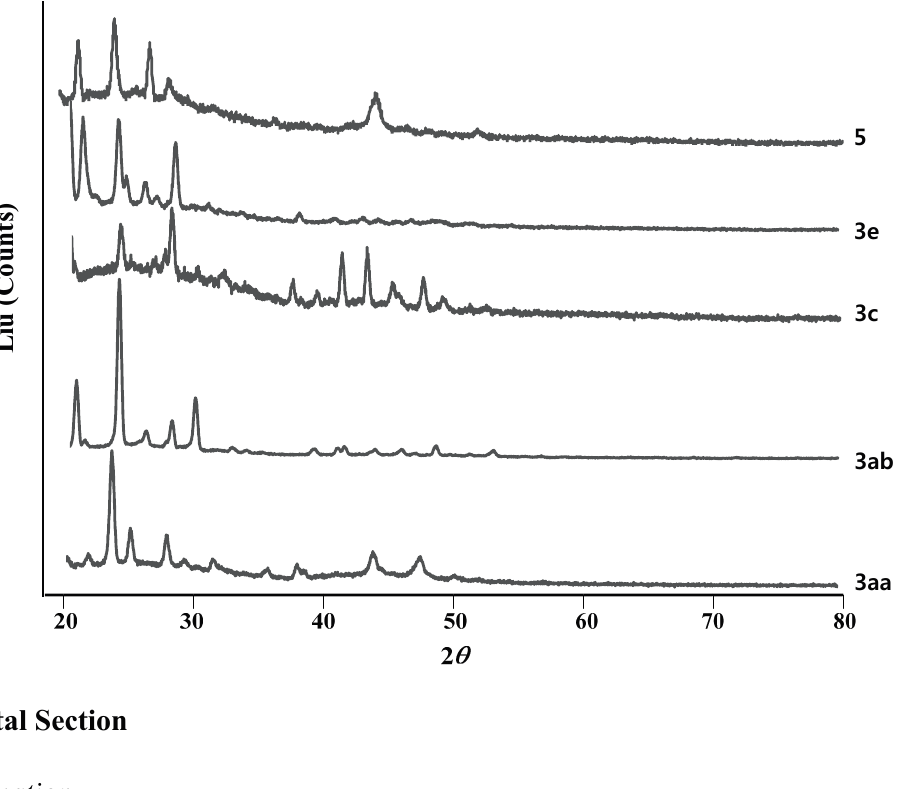
Figure 3. X-ray diffractograms of compounds prepared in powder